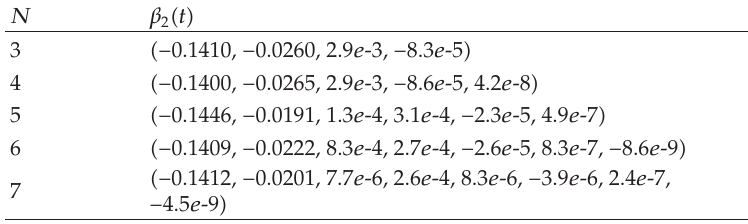
Table 1: Inversion results for β 2 (cid:3) t (cid:6) in higher-order polynomials.